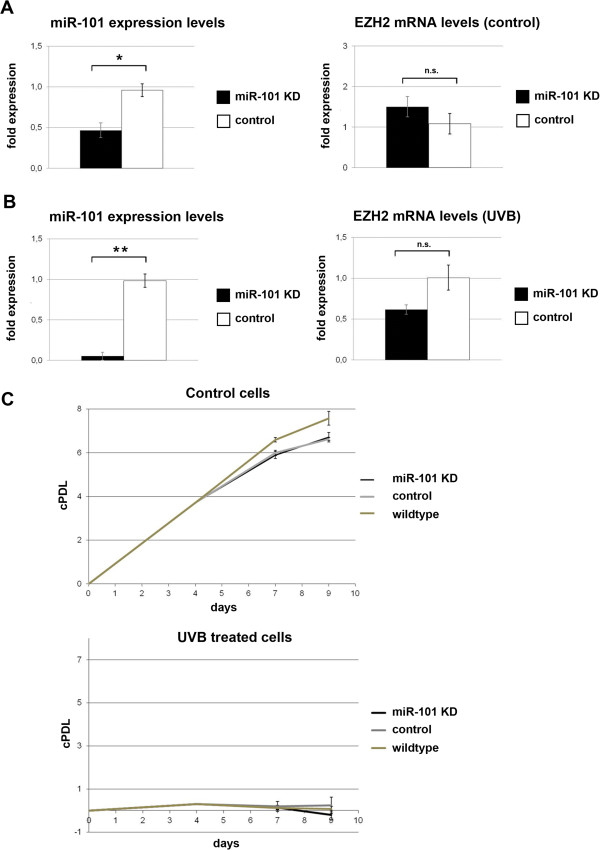
Depletion of miR-101 fails to prevent UVB-induced senescence. Cells were irradiated with UVB twice a day for 4 days. After the last exposure the cells were reverse transfected as described with miR-101 power inhibitors for knockdown, negative control or not treated. Reverse transfection was repeated at day 7. At day 9 RNA and protein were isolated. A. Control cells. Expression levels of miR-101 and Ezh2 mRNA of non-irradiated cells after miR-101 knockdown were determined by real-time qPCR. Bars indicate the mean ± SE of three independent experiments. B. UVB-treated cells miR-101 and Ezh2 expression levels from UVB treated cells after miR-101 knockdown were determined by real-time qPCR. Bars indicate the mean ± SE of three independent experiments. C. Growth curve analysis of miR-101 knockdown cells. cPDLs were calculated as described. Data represent the mean ± SD of three independent experiments. cPDL: cumulative population doublings KD: knockdown. *p < 0.01; **p < 0.001.